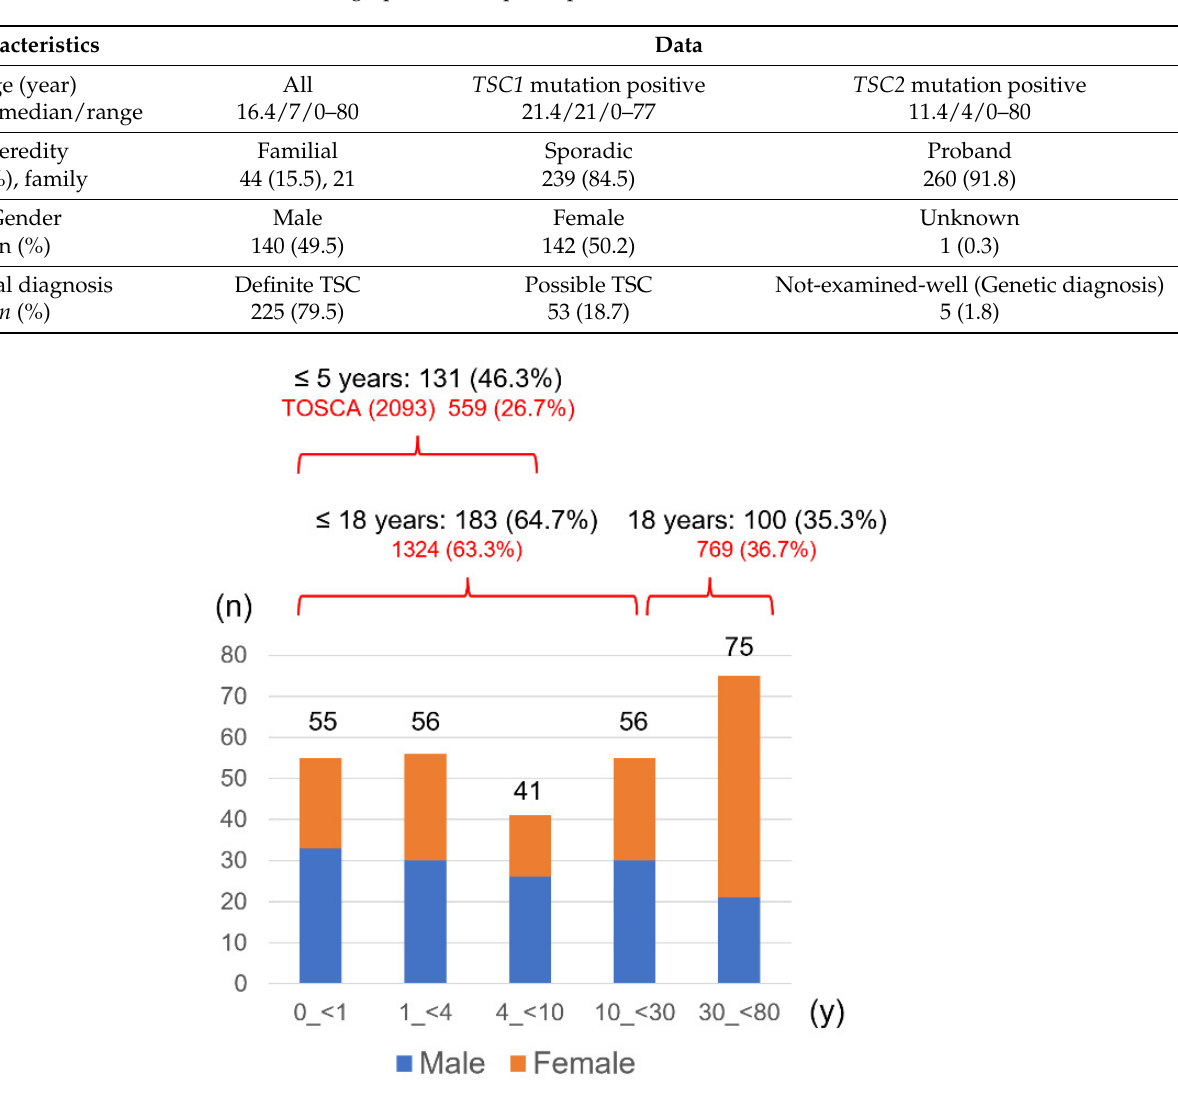
Table 1. Demographics of the participants ( n = 283).